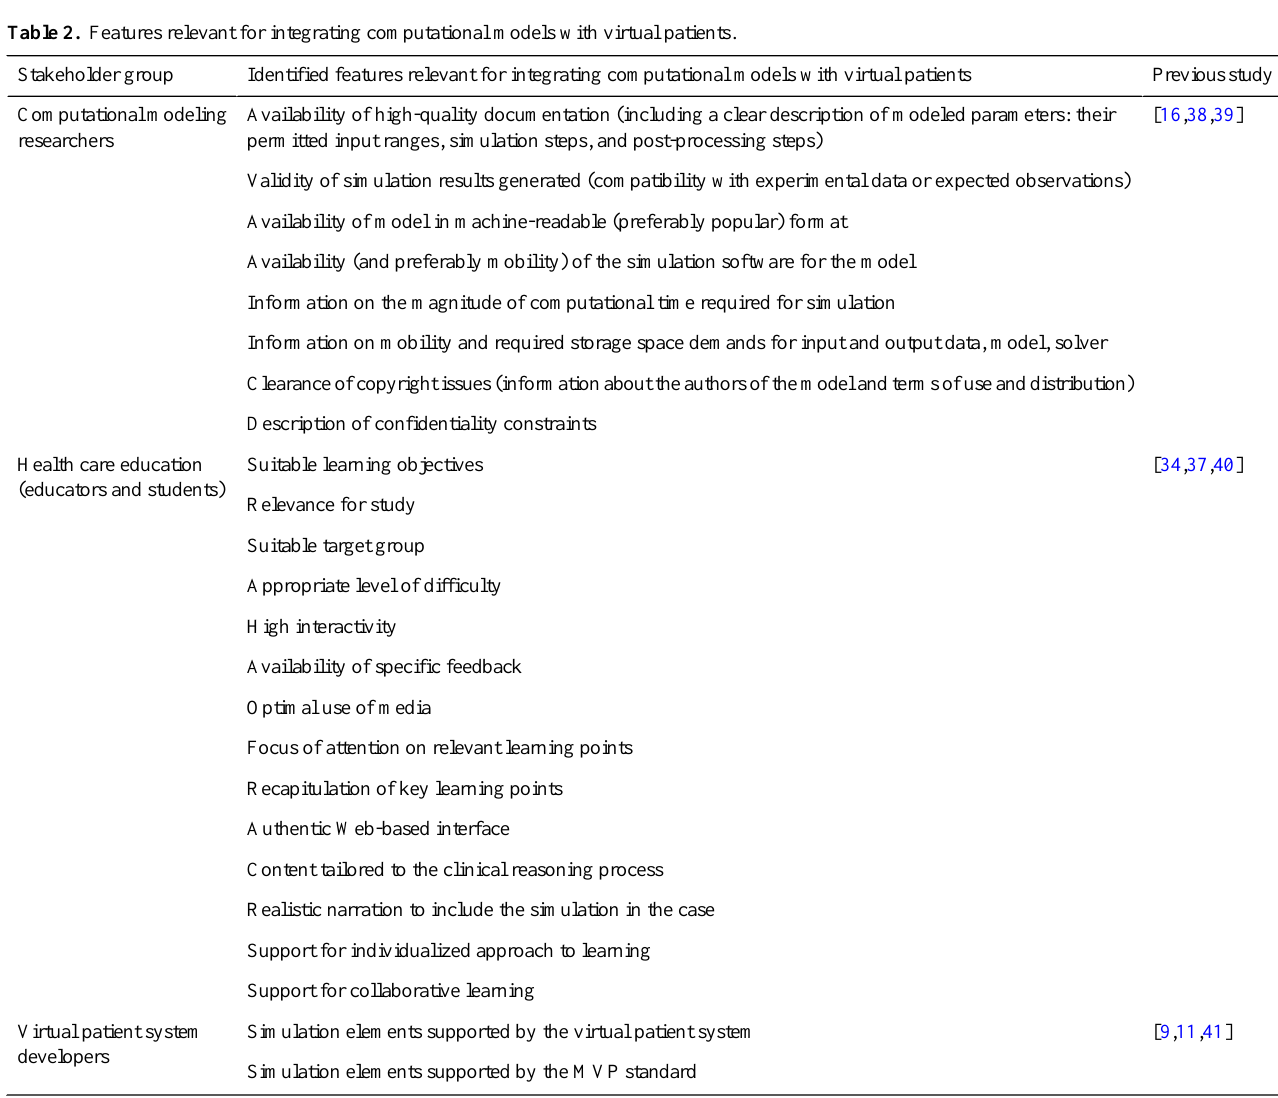
Table 2. Features relevant for integrating computational models with virtual